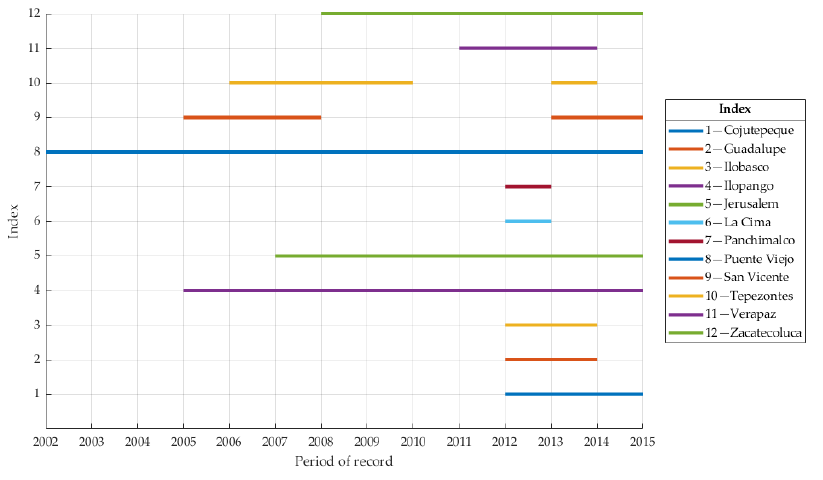
Figure 2. Period of record for telemetry rainfall stations surrounding the Jiboa